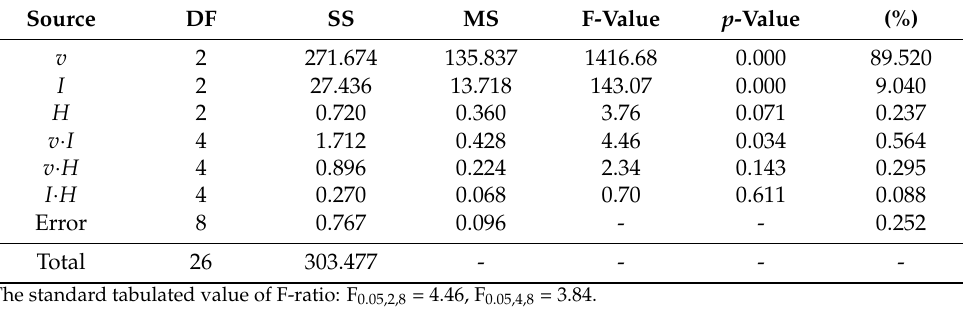
Figure 13. Experimental material removal rate vs. predicted material removal rate. Table 10. ANOVA for material removal rate.